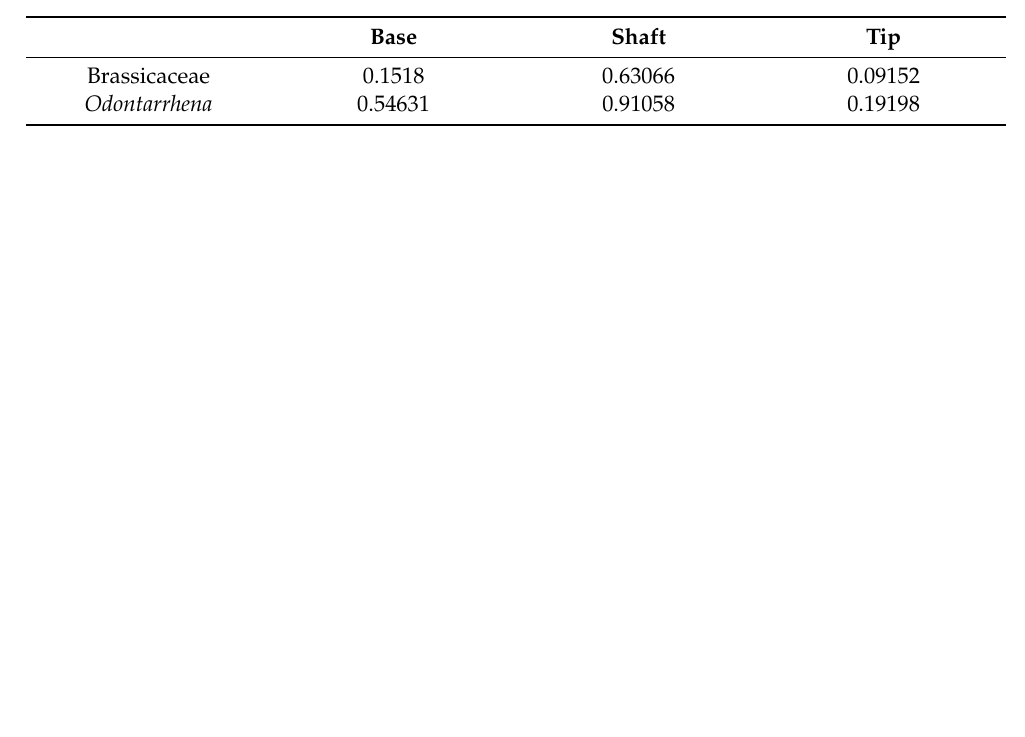
Table A2. Kruskal-Wallis p -values for pooled Mg:Ca-ratios of all cultivated species and for the genus Odontarrhena at base, shaft and tip at a p -value < 0.05